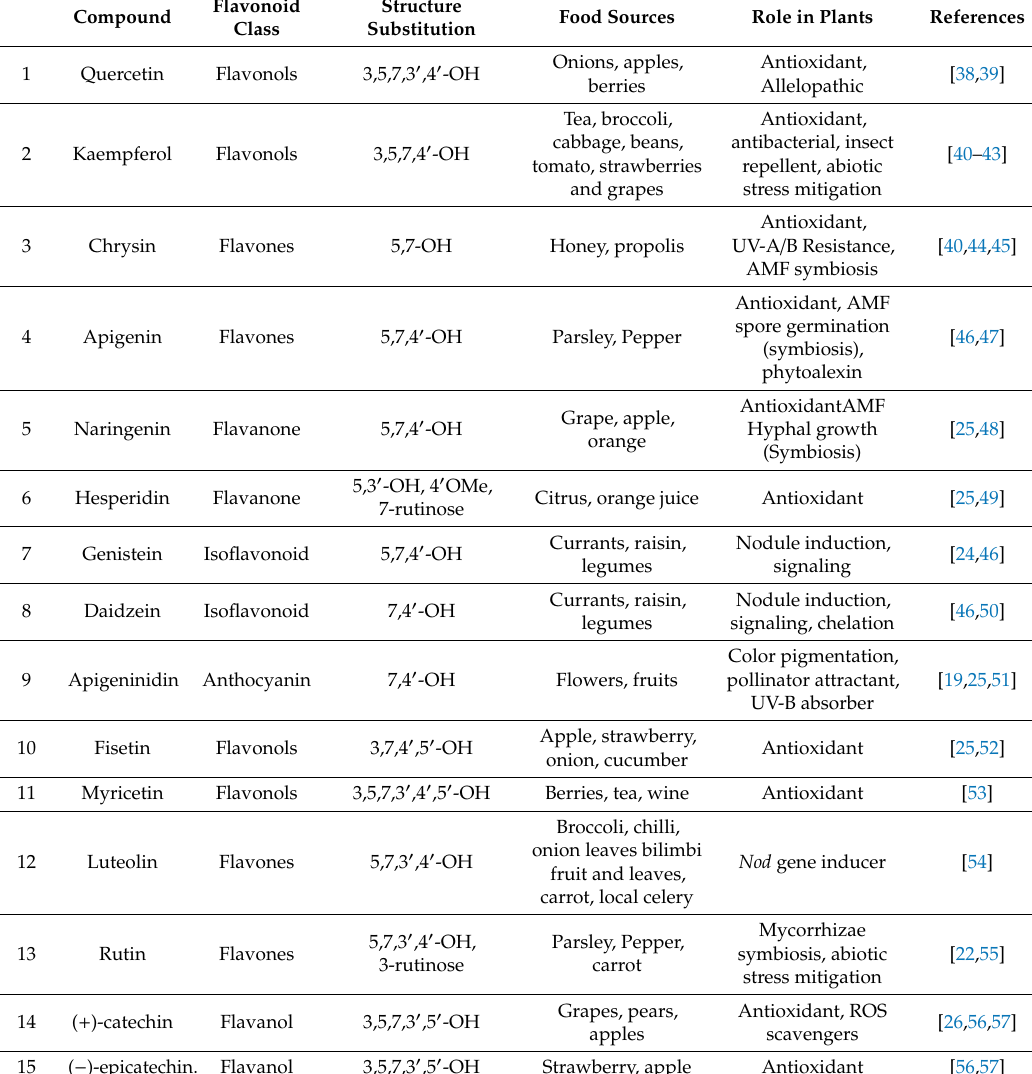
Table 1. Flavonoid subclasses, dietary sources, major functions in plants and structural substitutions in the basic skeleton. Flavonoid Structure Food Sources Role in Compound Class Substitution